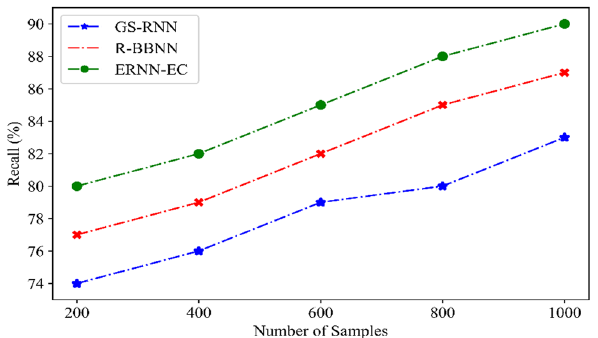
Figure 5: Comparison of